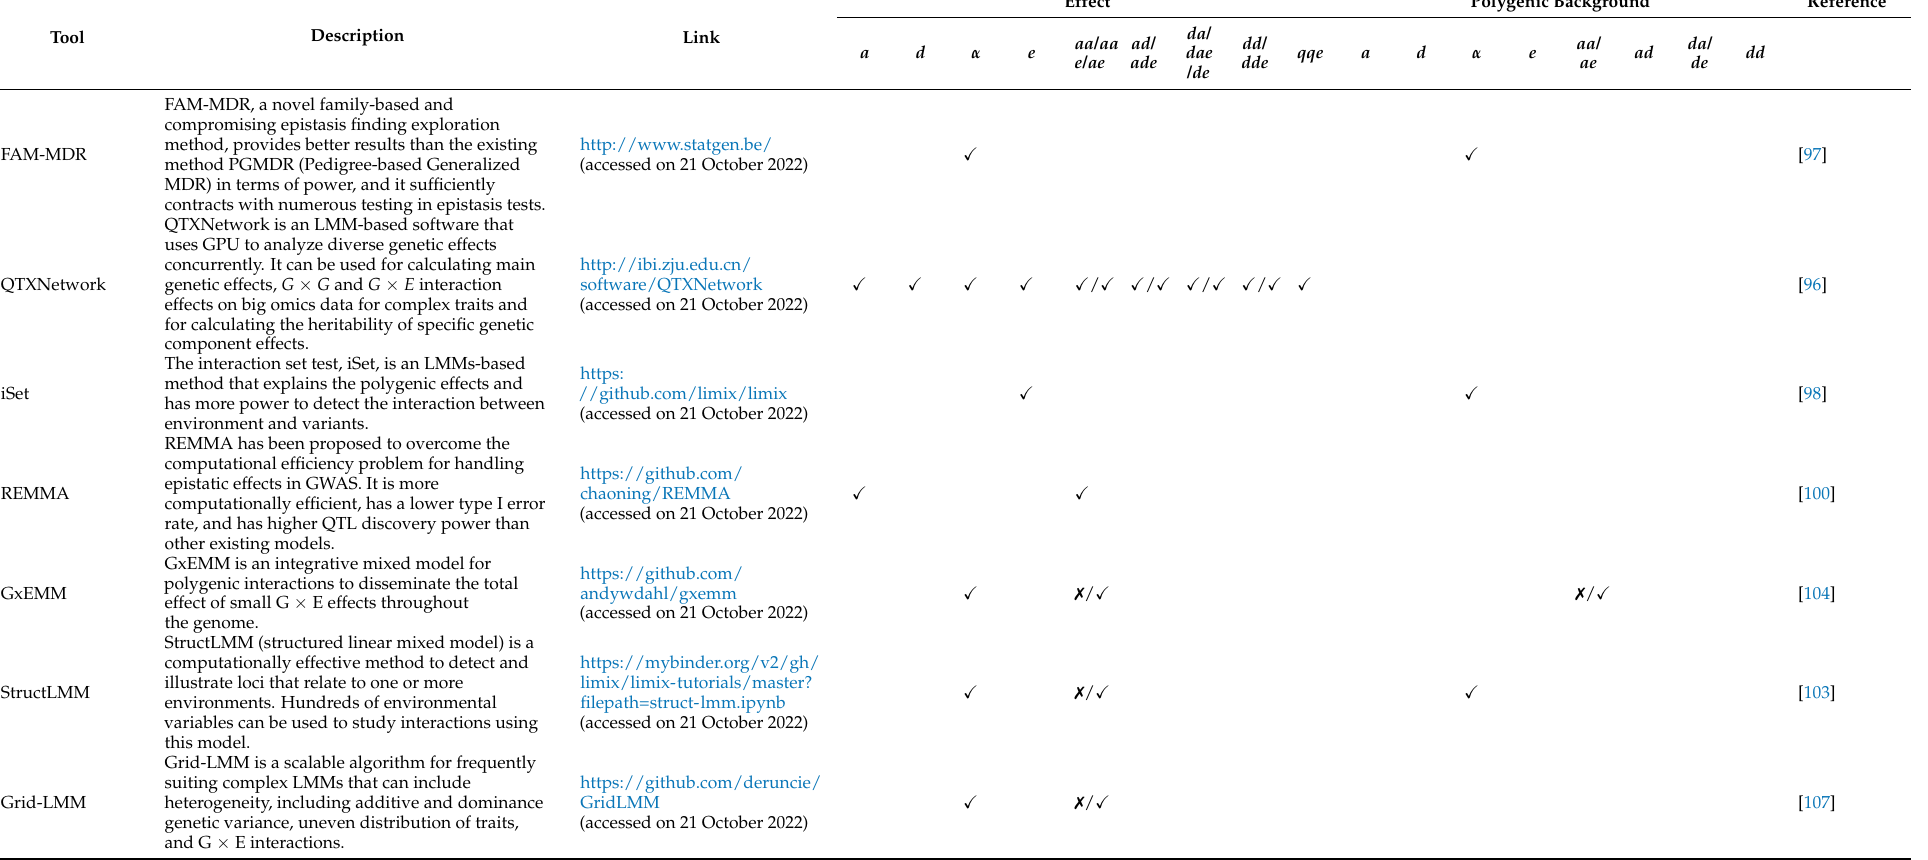
Table 4. Epistasis (G × G) and gene–environment (G × E) interaction and their respective software and packages for GWAS using